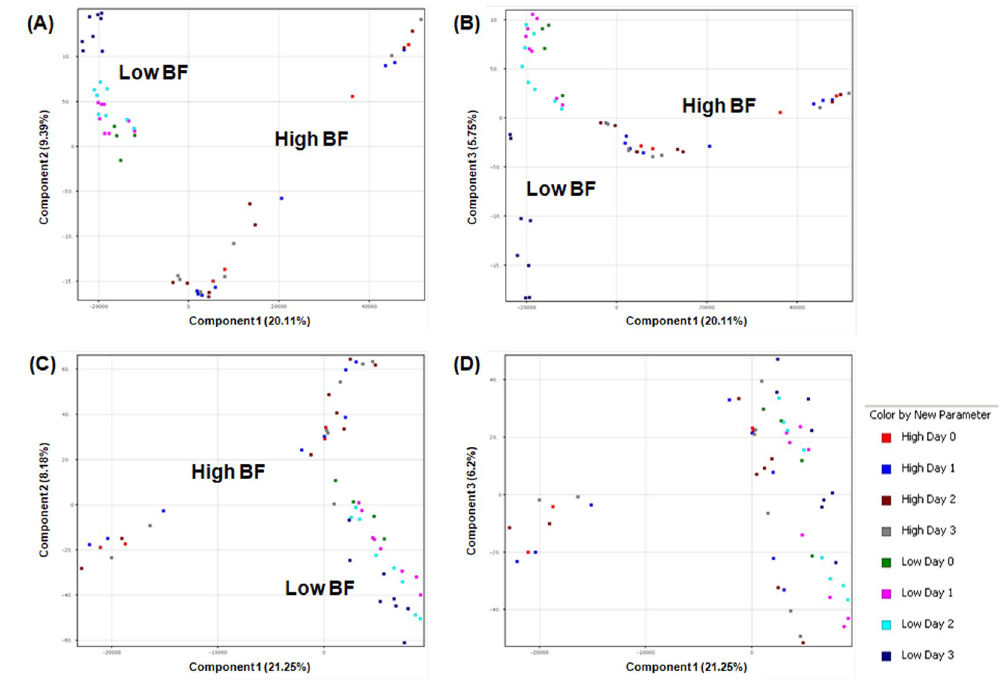
Figure 1. Two-dimensional principal component analysis (PCA) of 56 samples based on global metabolomic profiles. The PCAs were generated using MassHunter Mass Profiler Professional (MPP) software. There were 28 low and 28 high biofilm-forming samples. Independent replicates are available for Day 1 to 3 samples. Axes represent the principle components of the PCA and the numbers indicate the percentage of variance that is captured by each component. H. pylori strains formed distinct clusters on the basis of features acquired in positive ionization mode using ( A ) components 1 (20.11%) and 2 (9.39%), and components 1 (20.11%) and 3 (5.75%) ( B ). H . pylori strains formed distinct clusters on the basis of molecular features acquired in negative ion mode using components 1 (21.25%) and 2 (8.18%) ( C ) but not when components 1 (21.25%) and 3 (6.2%) was used ( D ). The scores shown by the axes scales are used to check data quality.